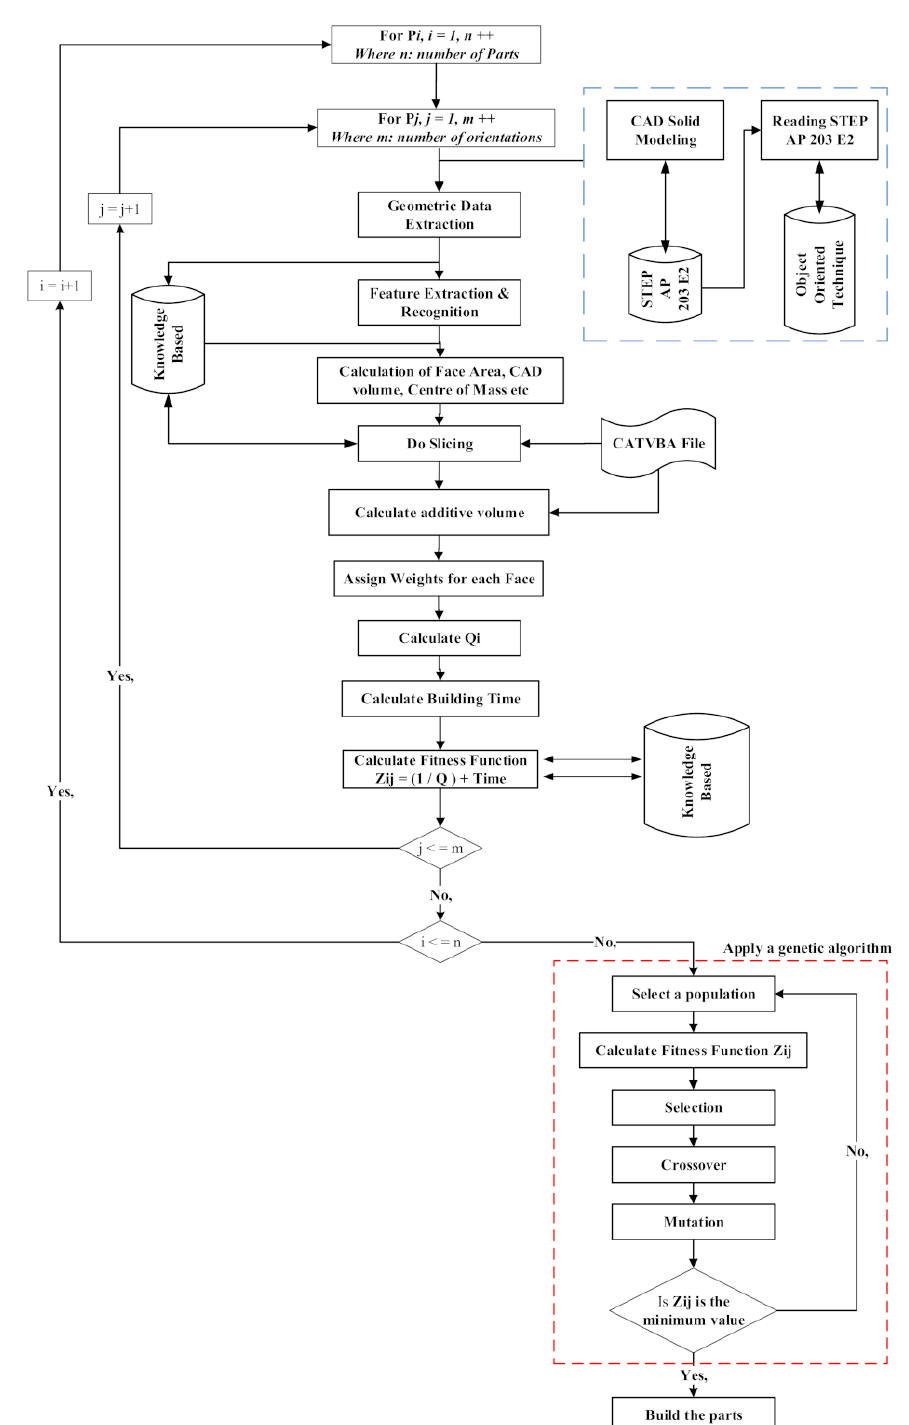
Figure 1. Methodology adopted to optimize orientation for multi-part